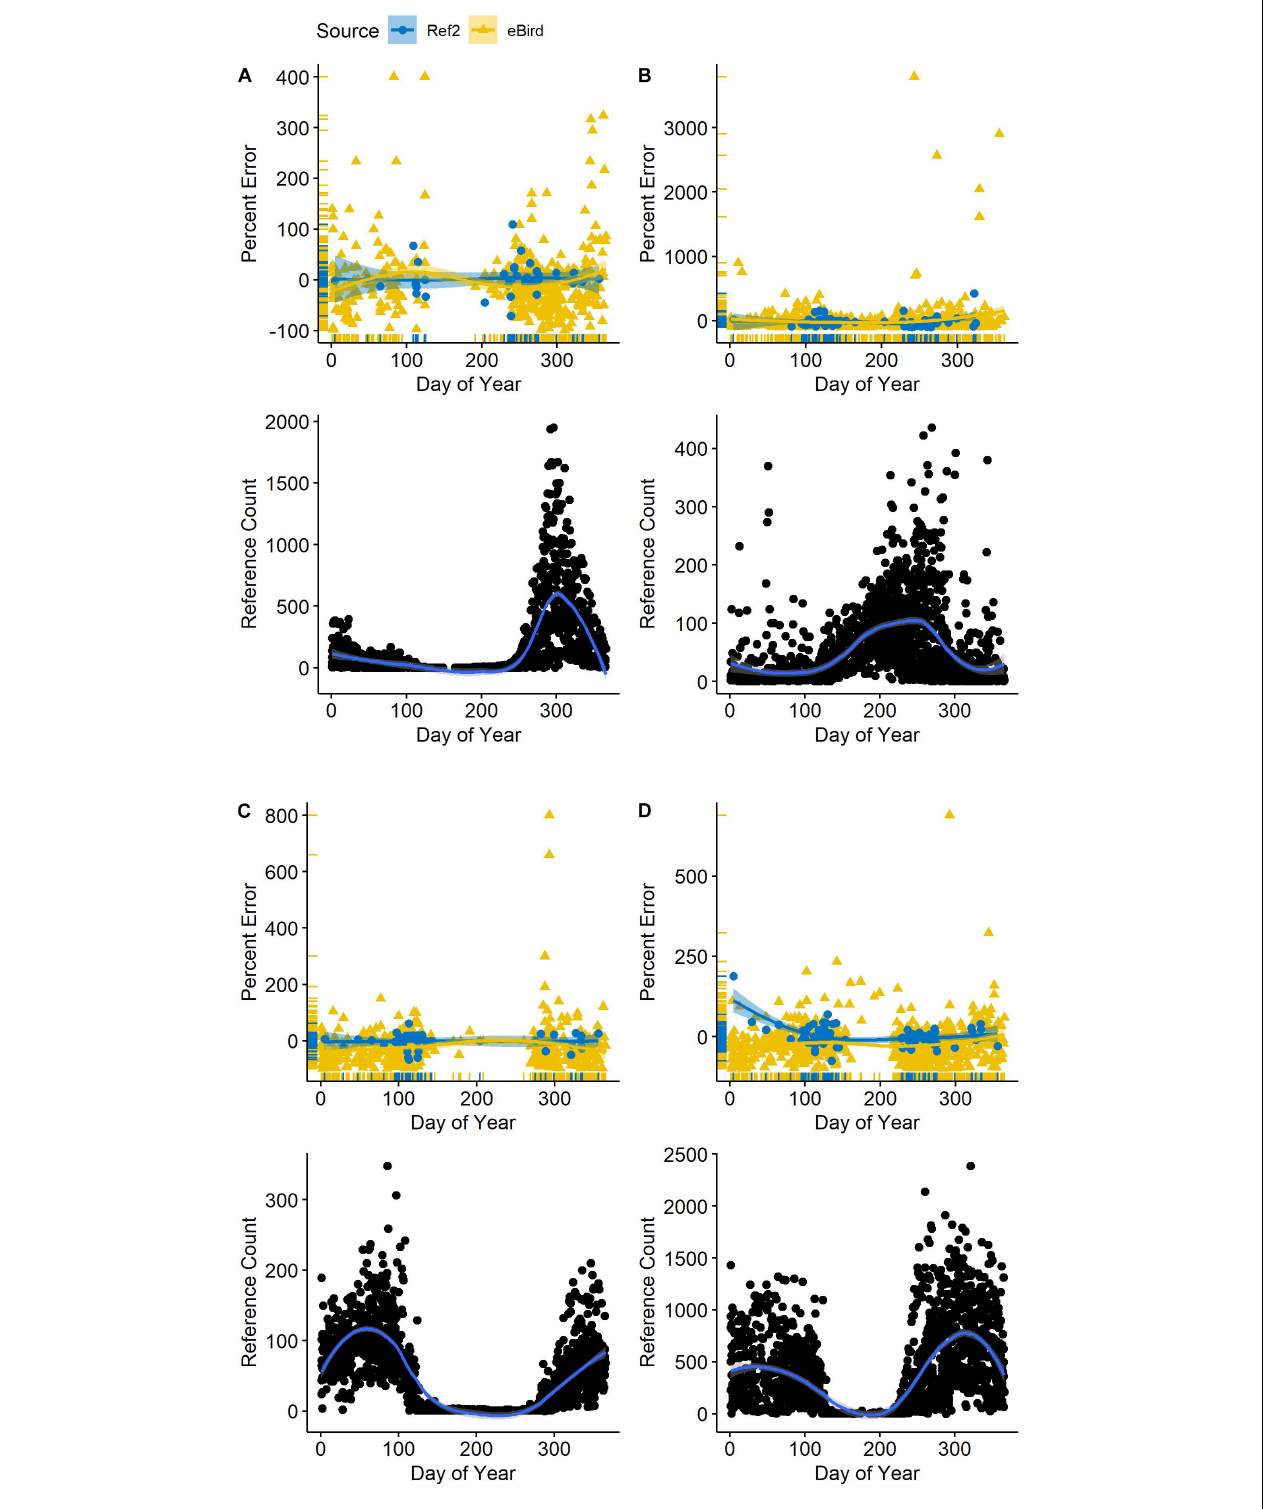
FIGURE 3 | Variation in reference (benchmark) counts ( R* ) as a function of date (lower panel) and counts reported in eBird (gold triangles in upper panel) alongside second-visit counts (Ref2; blue circles) at Philomath ponds, Oregon USA, 2010–2019. Counts in the upper panels are indicated with respect to the R* count (zero line) each day. Loess regression lines with 95% confidence intervals are included. (A) American Coot; (B) Mallard; (C) Lesser Scaup; (D) Northern Shoveler.